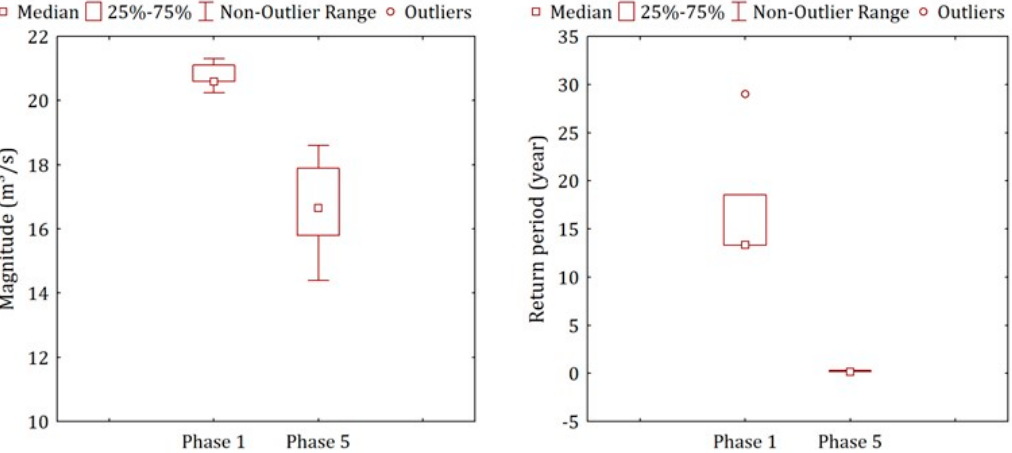
Figure 14. The comparison of the magnitude and return period of low flows in Phase 1 and Phase 5 during the hydropower dam disturbance period.